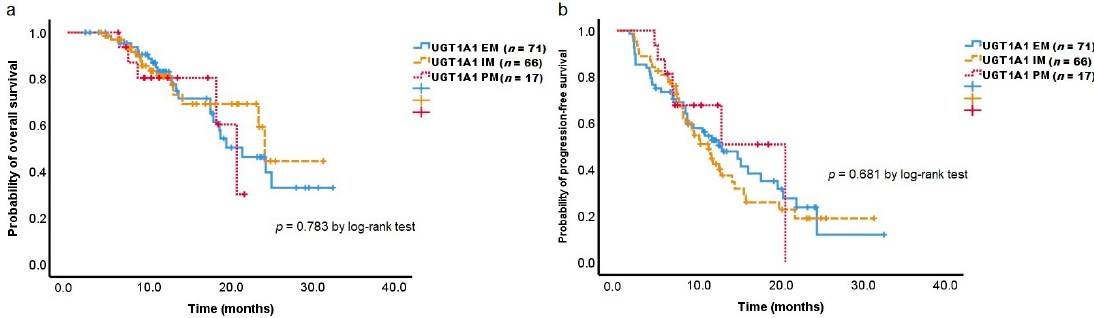
Figure 2. Kaplan–Meier estimates of overall survival ( a ) and progression-free survival ( b ) according to UGT1A1